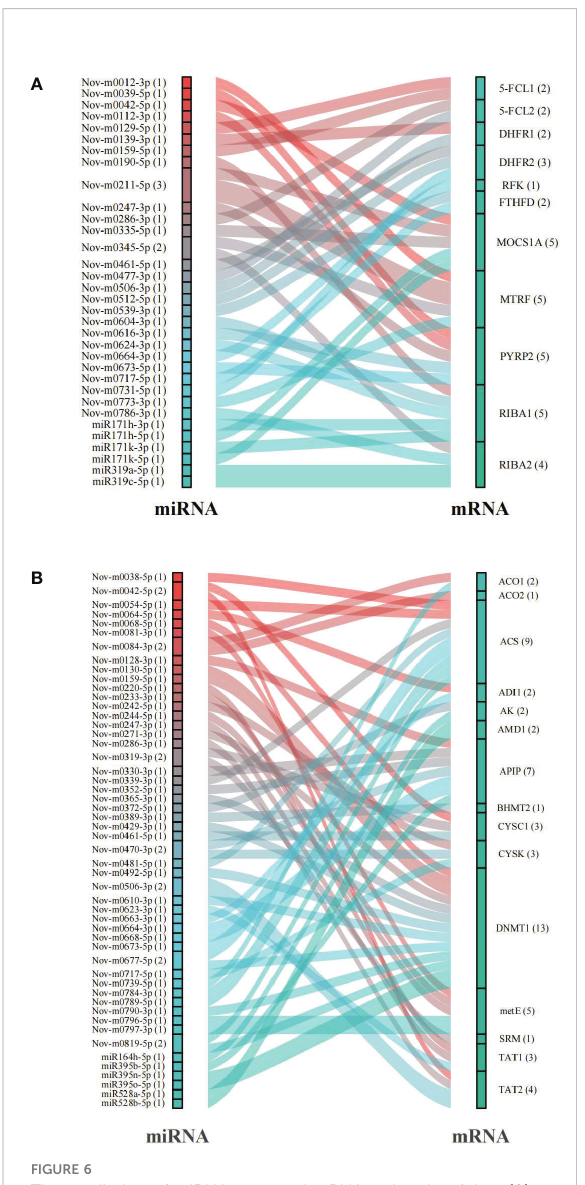
FIGURE 6 The prediction of miRNAs targeted mRNAs related to folate (A) and Met (B) metabolism pathway.